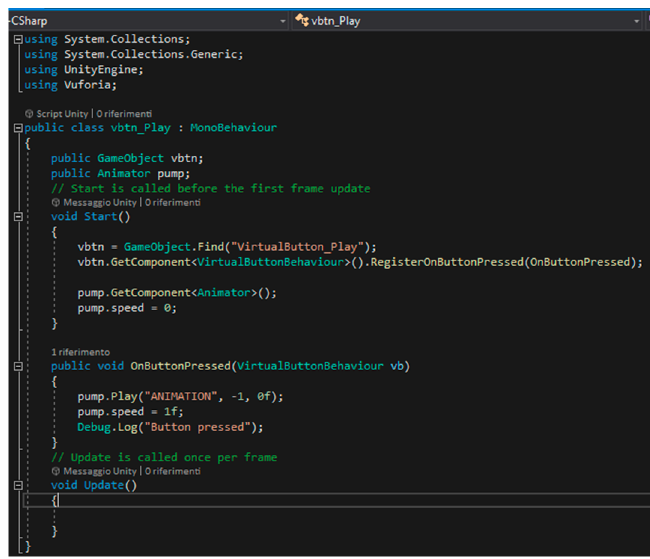
Figure 18. Script for the virtual button.